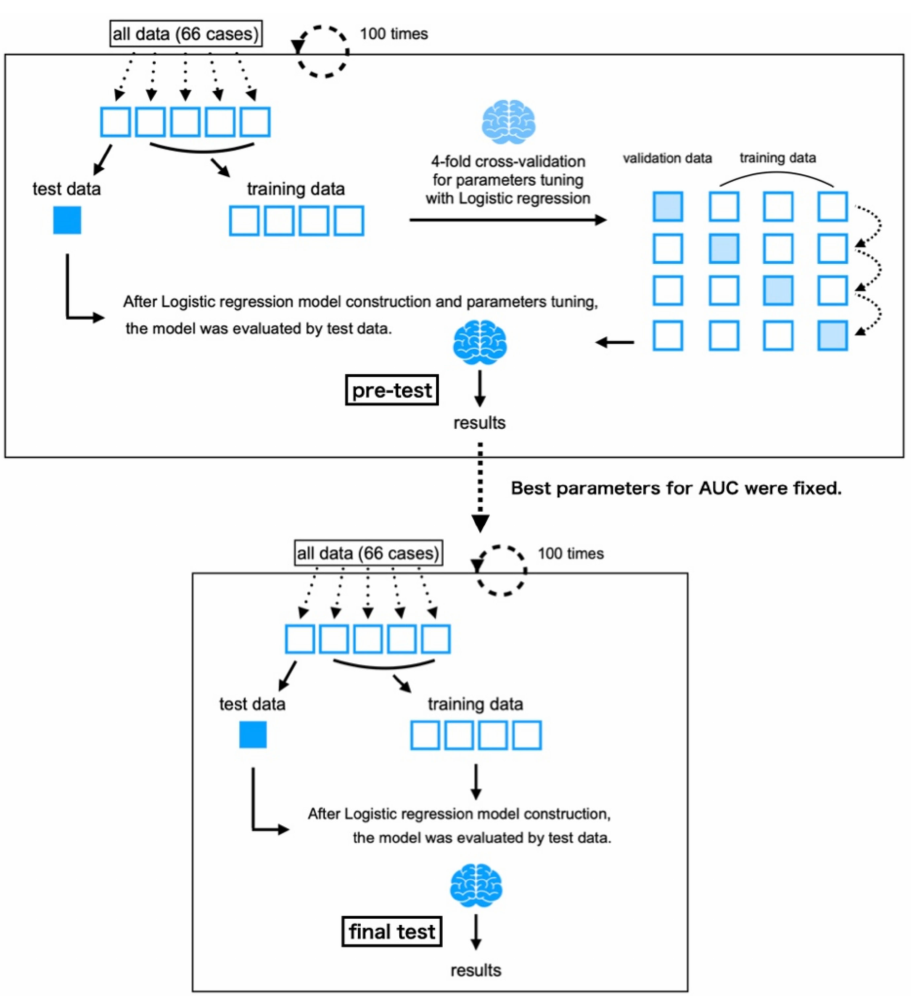
Figure 3. Algorithm shown in the box is a method of adjusting parameters to maximize the area under the curve (AUC). Then, as shown in the algorithm in the lower box, a logistic regression model was created with the training data by fixing the parameters at the most frequent values among those explored in the upper box, and the model was then evaluated with the test